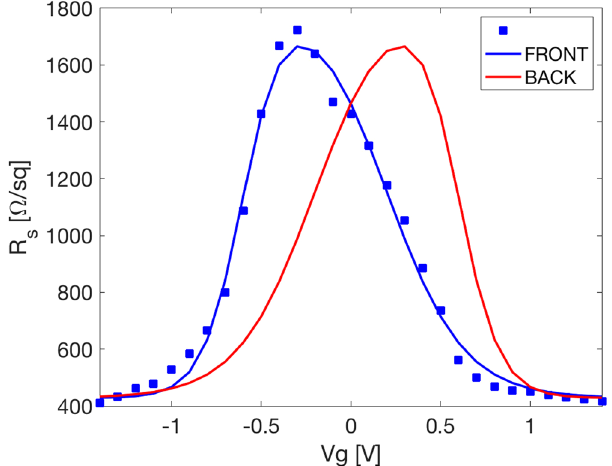
Figure 2. Experimental Rs values (blue points) of 2L graphene front electrode as a function of the applied gate voltage. The blue curve represents the fitting of experimental Rs data by means of an asymmetric double sigmoidal function. Red line represents the expected mirrored trend of Rs for the 2L back